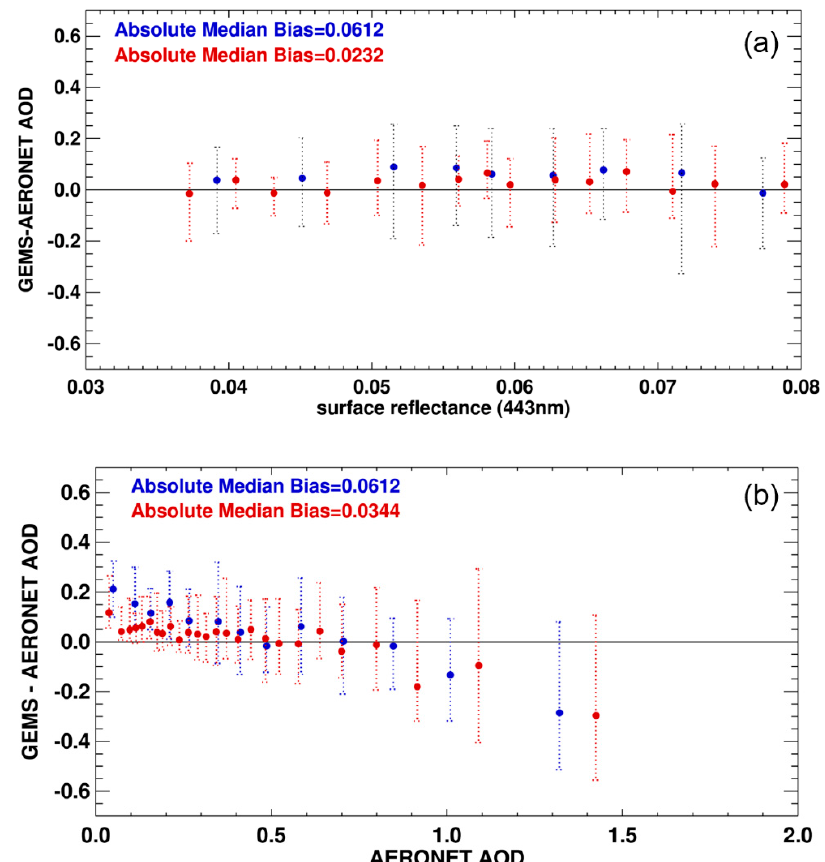
Figure 13. ( a ) Bias of GEMS AOD with respect to surface reflectance (443 nm), as used for AOD retrieval. ( b ) Bias of GEMS AOD with respect to collocated AERONET AOD direct-measurement data (L2). Blue and red refer to before and after aerosol fusion, respectively. The AMB was calculated for the total collocated blue and red points. Circles and bars represent median and SD values for 40 collocated data points for GEMS and AERONET data.